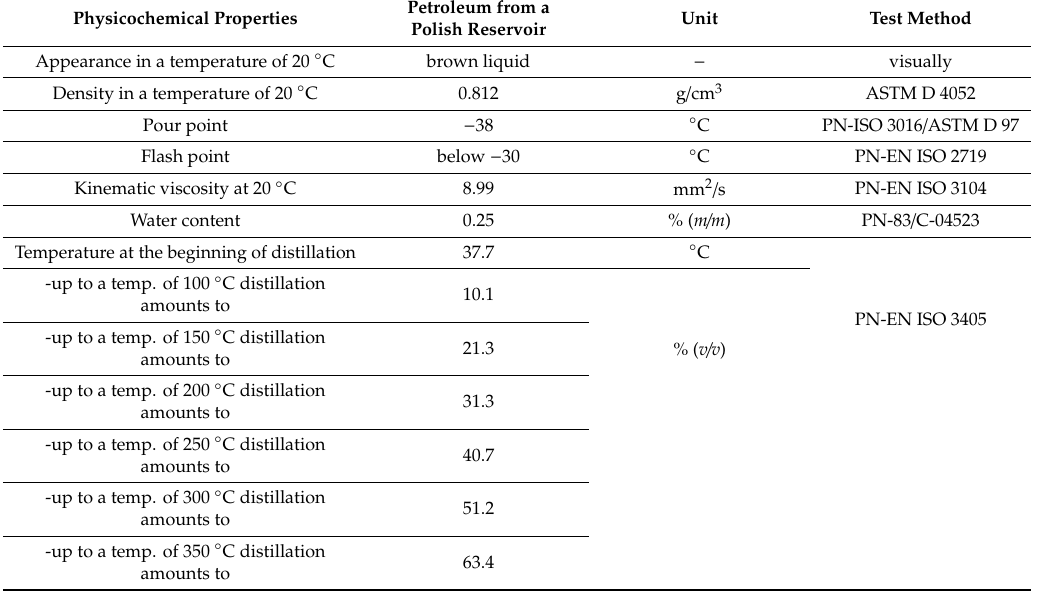
Table 3. Physicochemical properties of crude oil from a Polish reservoir selected for the tests. Physicochemical